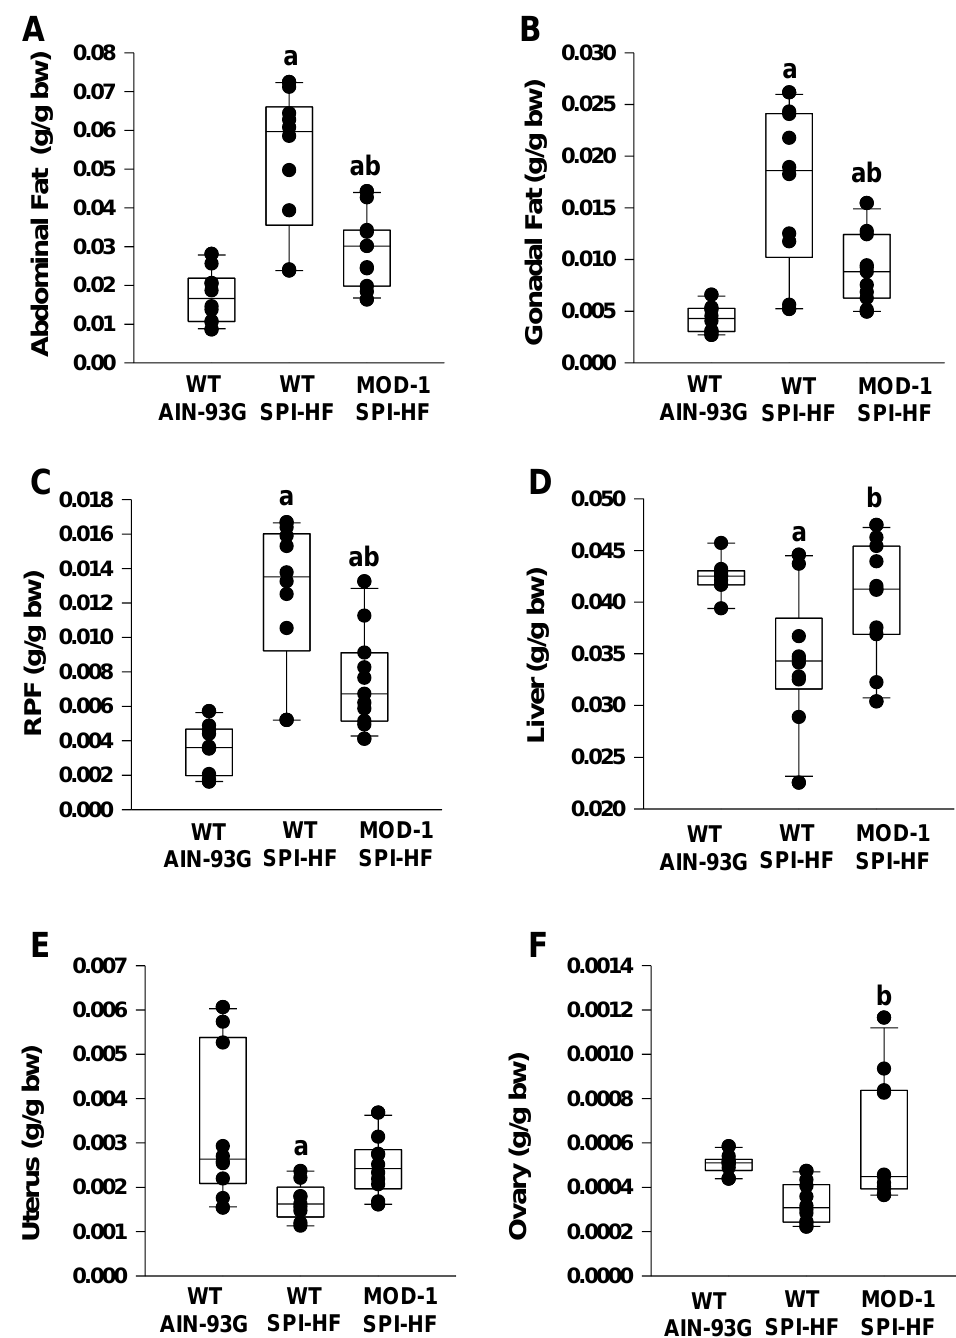
Figure 3. Organ weights (normalized to individual body weight) of female mice fed experimental diets. Mouse groups were n = 10 WT AIN-93G; n = 10 WT SPI-HF; n = 11 MOD-1 SPI-HF. ( A ) Abdom- inal fat depot, ( B ) gonadal fat depot, ( C ) retroperitoneal fat (RPF) depot, ( D ) liver, ( E ) uterus, and ( F ) ovary. Box plots indicate the upper and lower quartiles, interquartile range, and median (middle line), with whiskers showing maximum and minimum points within 1.5 × the interquartile range. Significant group differences are indicated by a and b ( p < 0.05); a indicates p < 0.05 compared to the WT AIN-93G group and b indicates p < 0.05 for WT SPI-HF vs. MOD-1 SPI-HF